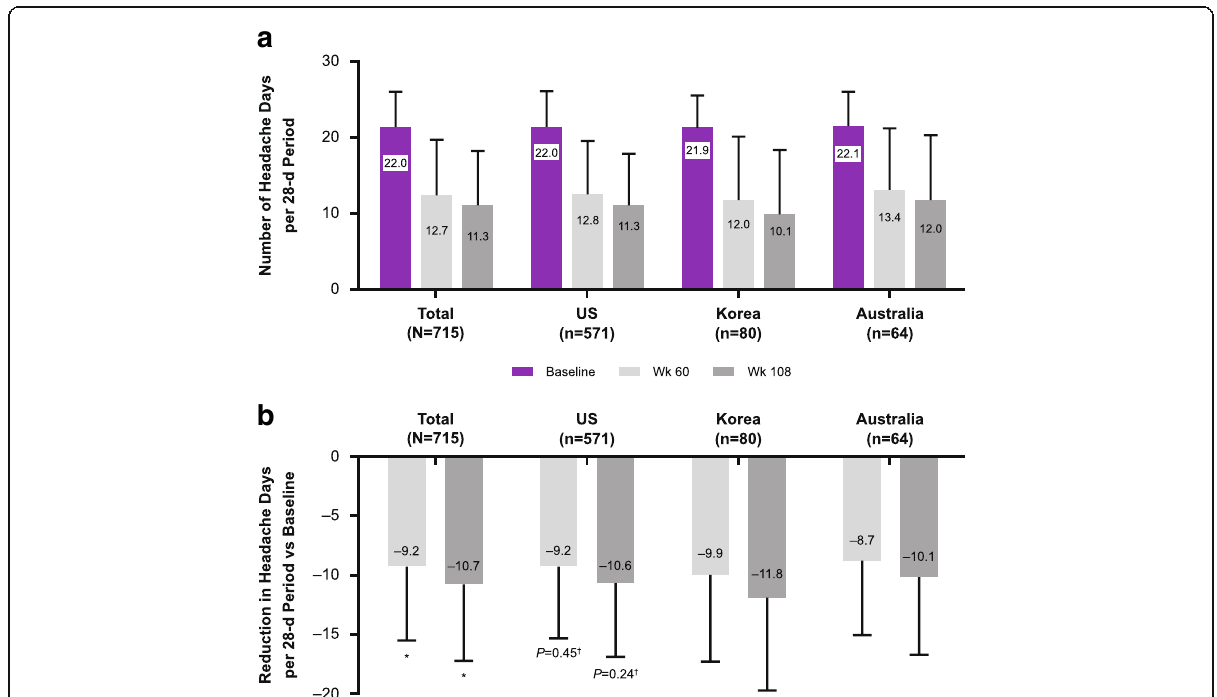
Fig. 6 Long-term effect of onabotulinumtoxinA by country. a ) Number of headache days per 28-d period and b ) change in number of headache days vs baseline, depicting the outcomes after 5 (wk 60) and 9 (wk 180) treatments. * P < 0.001; paired t -test used to compare visit to baseline. † P -value for comparing among subgroups is from one-way analysis of variance